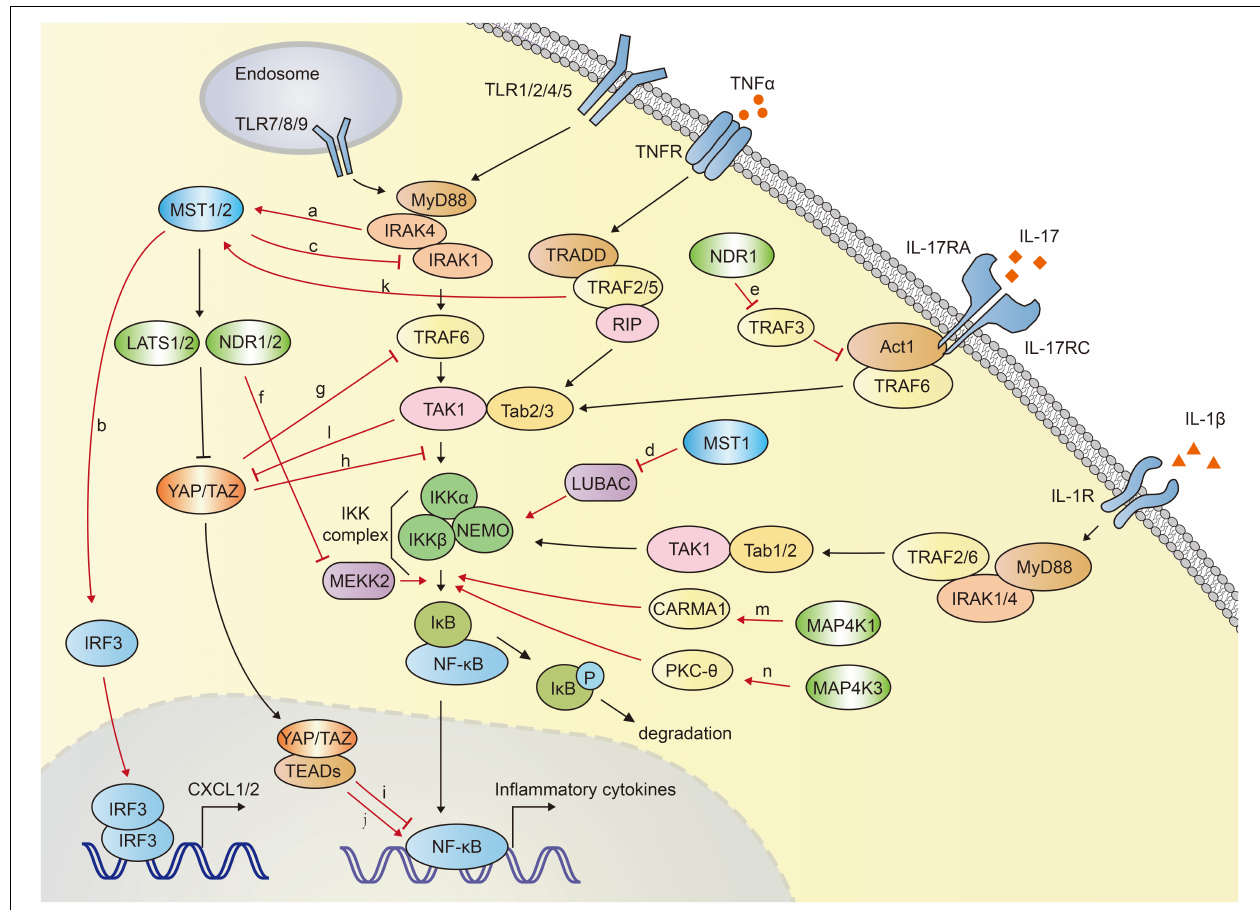
FIGURE 4 | The crosstalk between Hippo-YAP pathway and NF- κ B signaling. MST1/2 is activated via TLR2-MyD88-IRAK1/4 cascade during Mtb infection (a) , and subsequently induce the expression of CXCL1 and CXCL2 by activating IRF3 (b) . MST1 inhibits NF- κ B activation via promoting IRAK1 degradation (c) and inhibiting LUBAC-mediated NEMO linear ubiquitination (d) . MST1 is activated by TRAF2 after TNF α stimulation. NDR1 promotes the IL-17-induced inflammatory response by interact with TRAF3, which disrupts the IL-17R-Act1-TRAF6 complex (e) . NDR1/2 inhibit inflammatory cytokine production by promoting Smurf1-mediated degradation of MEKK2 (f) . YAP blocks NF- κ B activation via promoting the TRAF6 degradation (g) or disrupting the interaction between TAK1 and IKK α / β (h) . YAP/TAZ-TEADs complex inhibits the transcriptional activation of NF- κ B targeted genes in low-density-cells (i) . Long-term expression of YAP/TAZ in